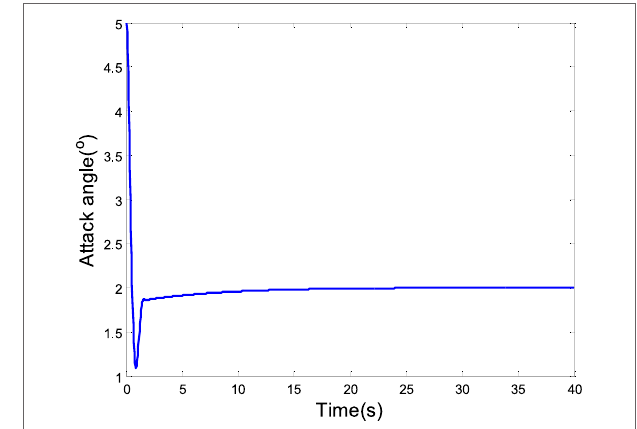
FIGURE 2 | Tracking attack